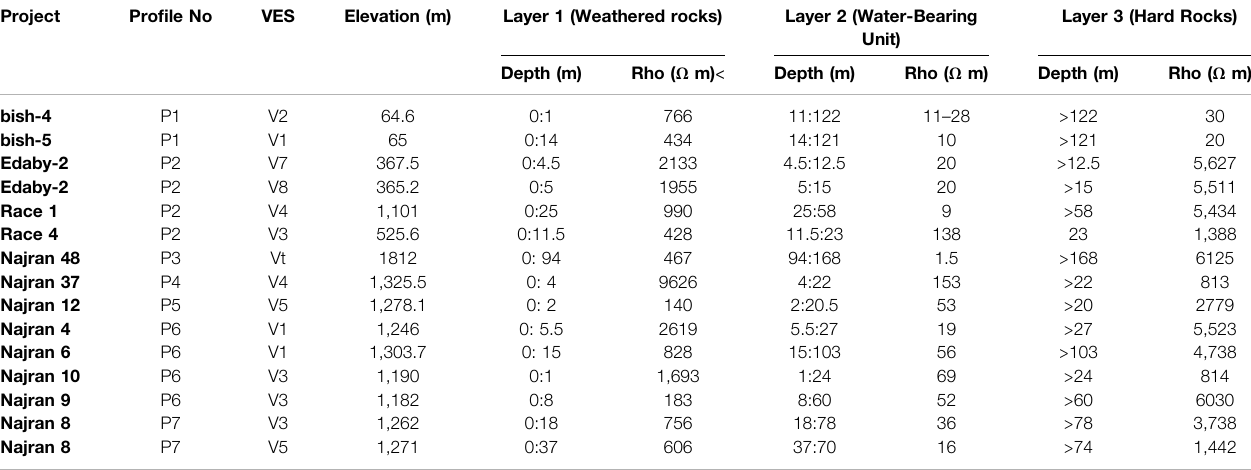
TABLE 2 | The resistivity ( Ω .m) and depth (m) values for the various inverted geoelectrical layers.